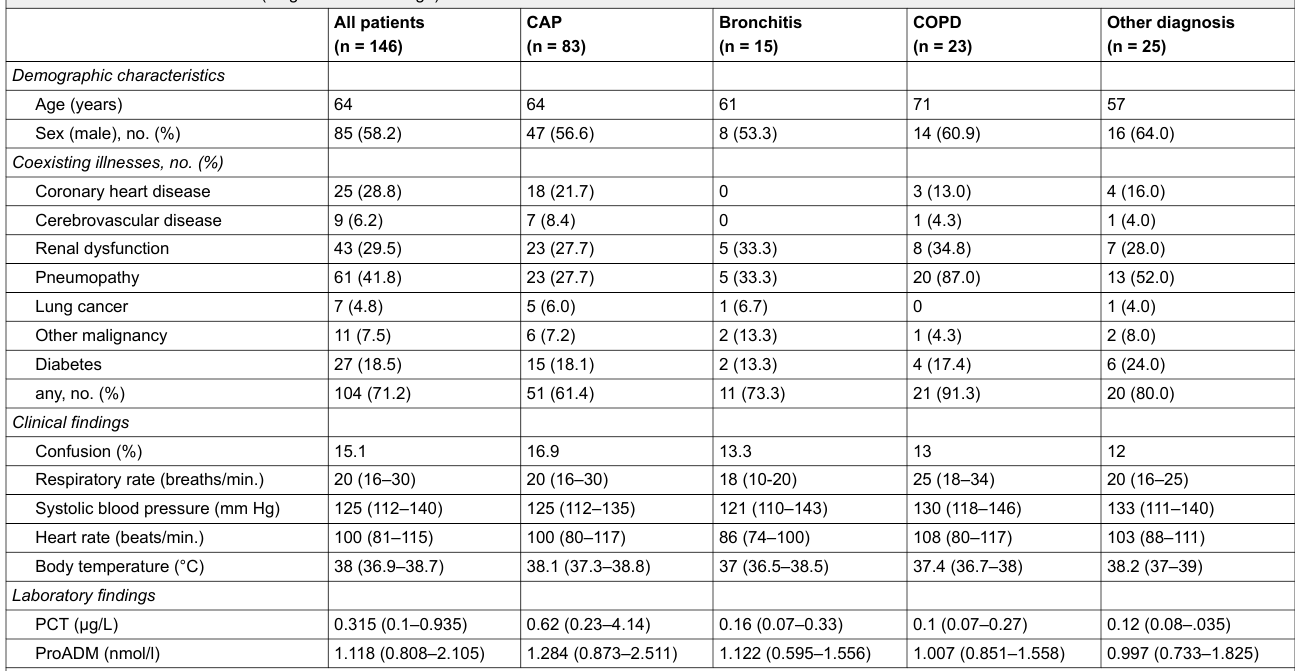
Table 1: Baseline characteristics (diagnosis at discharge).